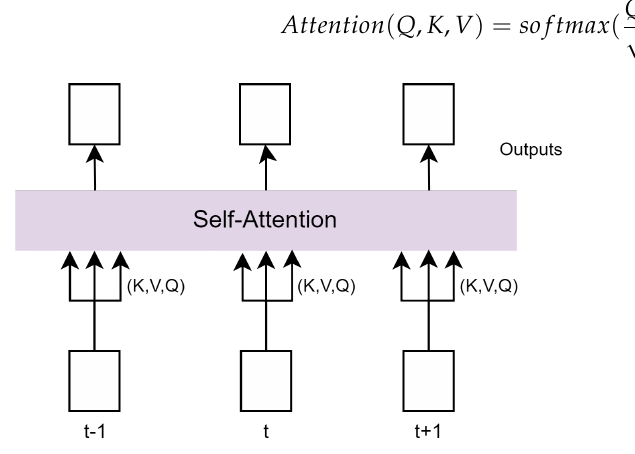
Figure 2. Self-attention